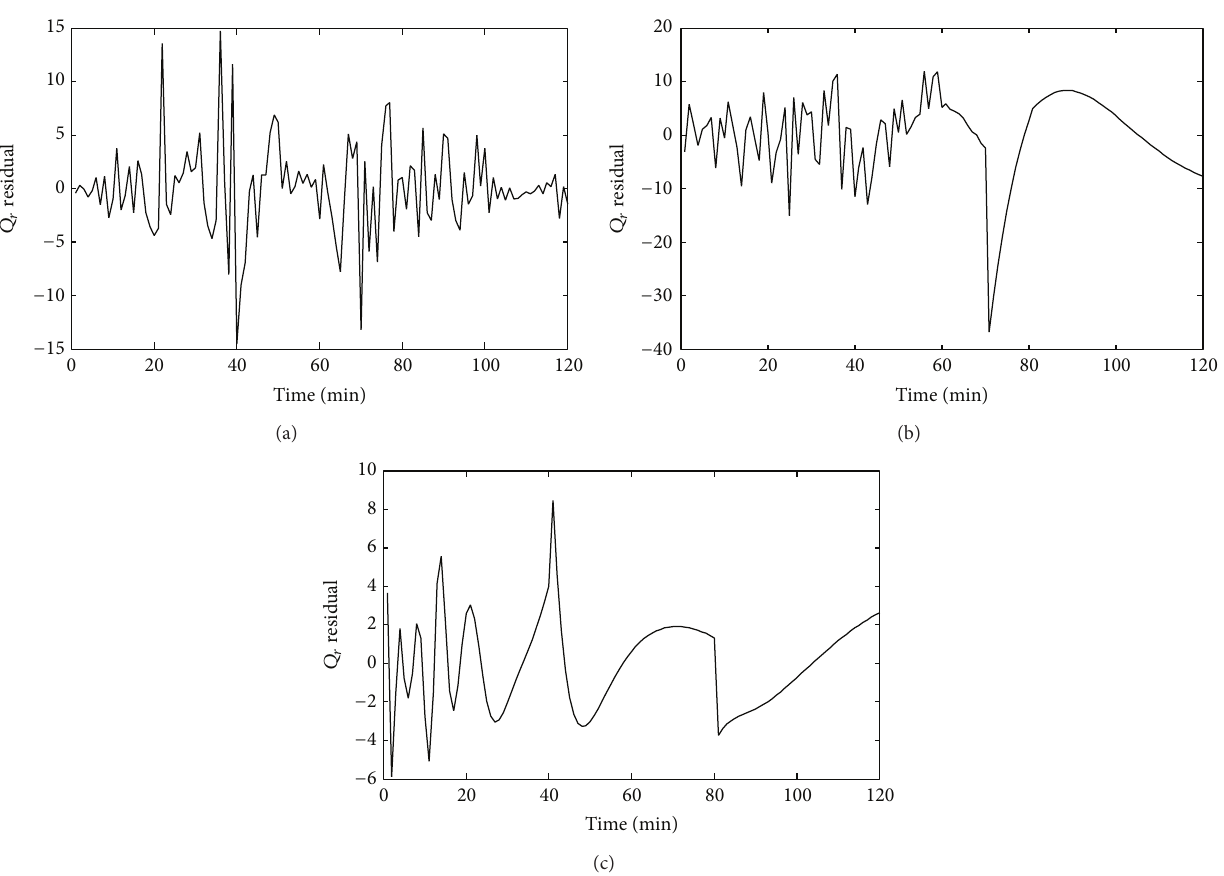
Figure 14: Residual (in terms of 𝑄 𝑟 ) due to sensor fault. (a) Residual (in terms of 𝑄 𝑟 ) due to reactor temperature sensor measurement with white noise. (b) Residual (in terms of 𝑄 𝑟 ) due to abrupt zero in reactor temperature sensor measurement. (c) Residual (in terms of 𝑄 𝑟 ) due to bias in jacket temperature sensor